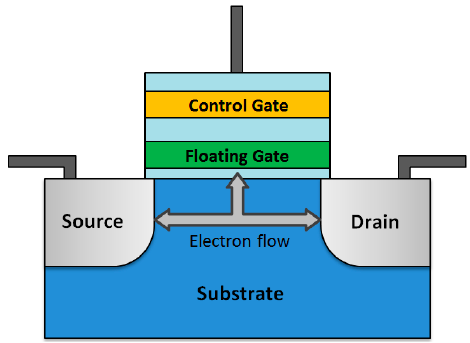
Figure 3. Cross-section of a FGMOS transistor. The transversal voltage between the channel and the control gate attracts part of the electron flow (from source to drain) to the floating gate. This additional kinetic energy injects the charges into the FG, where they remain until an inverse voltage is